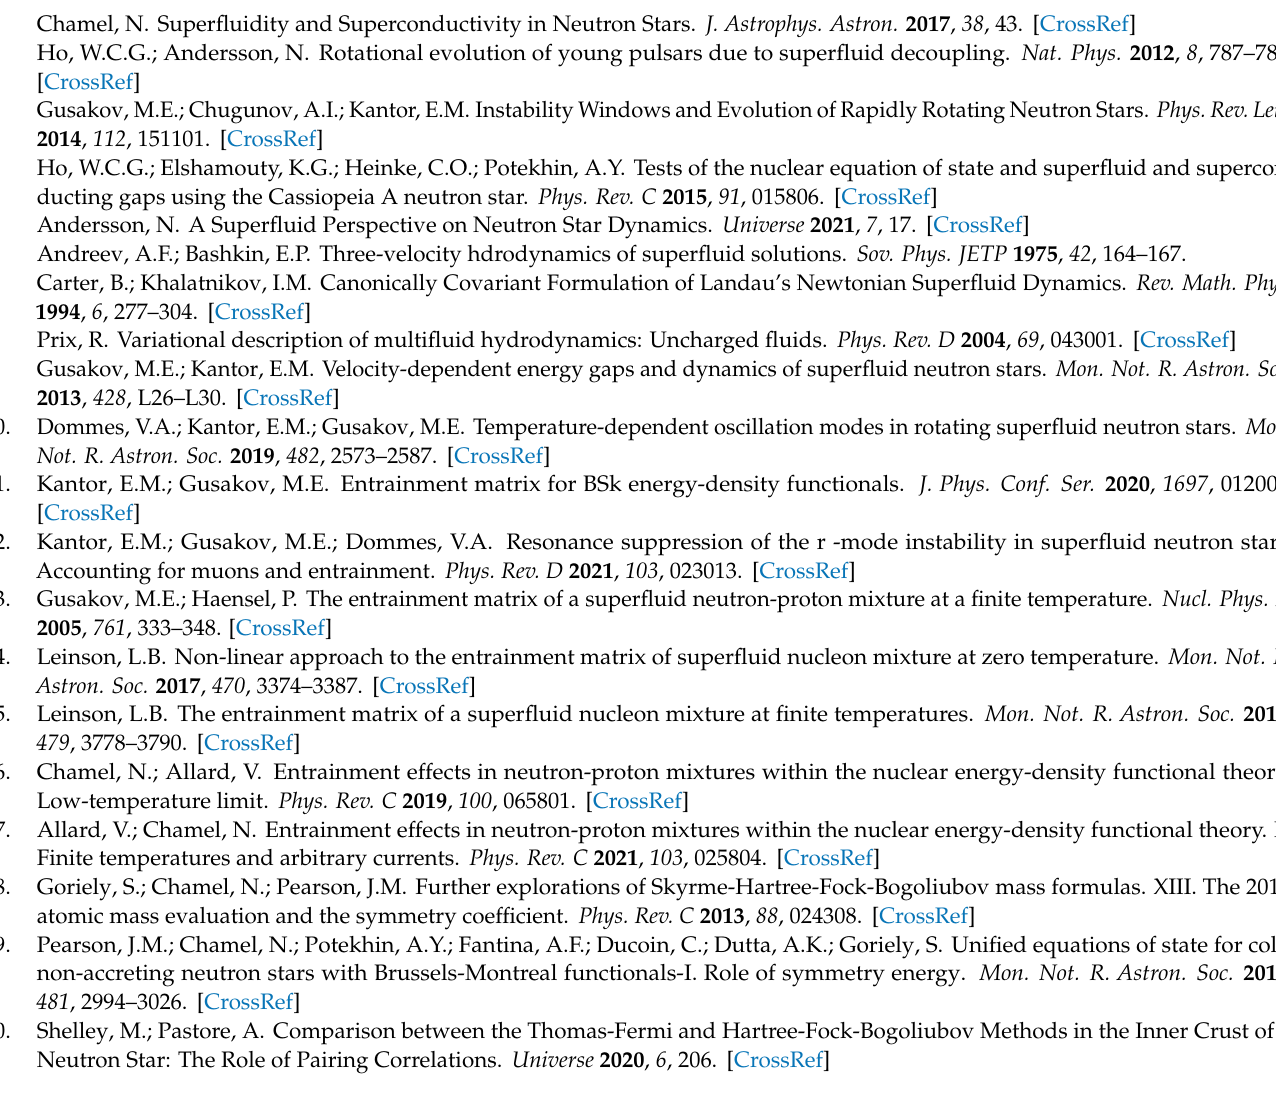
Following [15], the weak-coupling approximation ˘ ∆ q , ˘ ∆ place the inverse hyperbolic sine function by its asymptotic form asinh ( u ) ≈ log ( 2 u ) . Taking the limit ε Λ / ε Fq → + ∞ and x min → − ∞ and eliminating v π q ˘ D ( 0 ) leads to Equation (59). Please note that unlike the original gap Equation (A1), the limit ε Λ / ε Fq → + ∞ can be taken here since the integral does not exhibit any